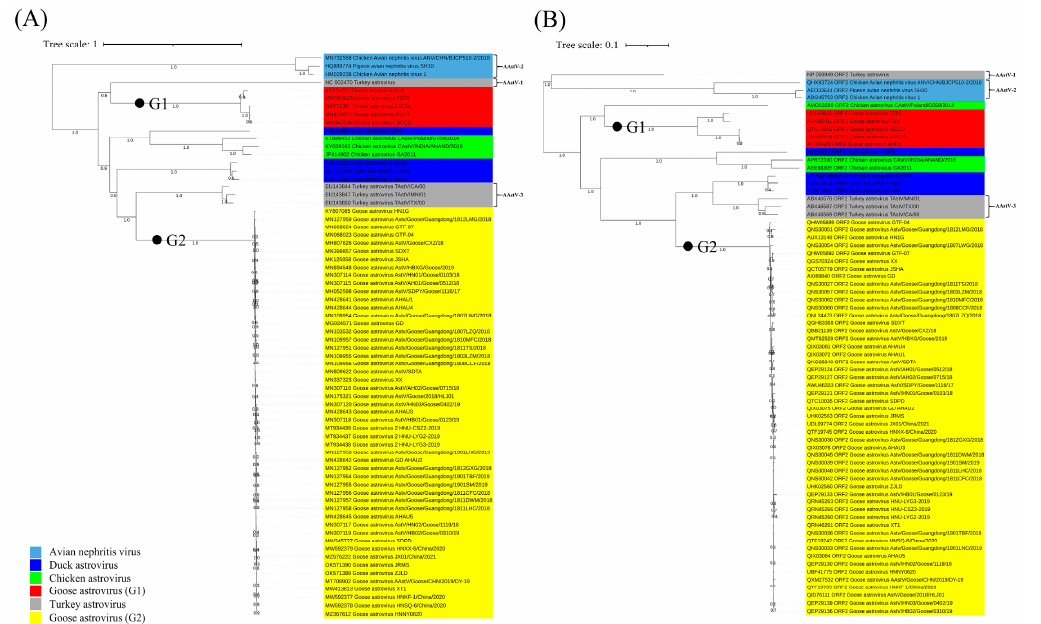
Figure 3. Phylogenetic analysis of GoAstV. ( A ) Phylogenetic analysis of GoAstV strains based on the whole genome. ( B ) Phylogenetic analysis of GoAstV strains based on the ORF2 aa sequence. Phylogenetic trees were generated based on whole genome and the ORF2 aa sequence using the neighbor-joining method with 1,000 bootstrap replicates as determined with MEGA 6.0 software.